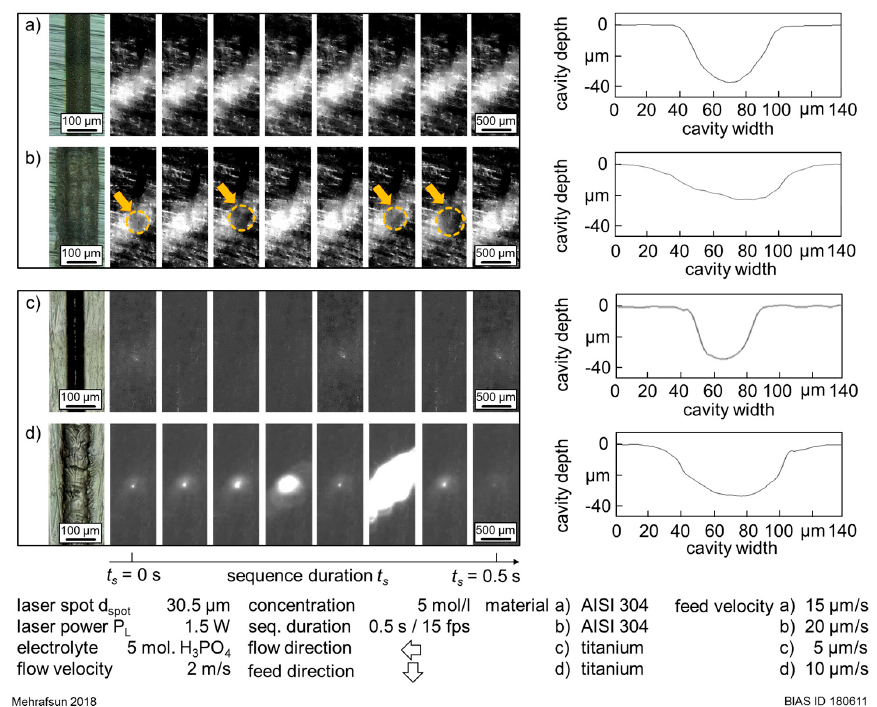
Figure 10. CCD snapshots of the LCM interaction zone at the transition from a disturbance ‐ free to a disturbed removal as well as the corresponding removal profiles obtained in ( a , b ) stainless steel and ( c , d ) titanium in a 5 ‐ molar phosphoric acid solution depending on the feed velocity at P L = 1.5 W.